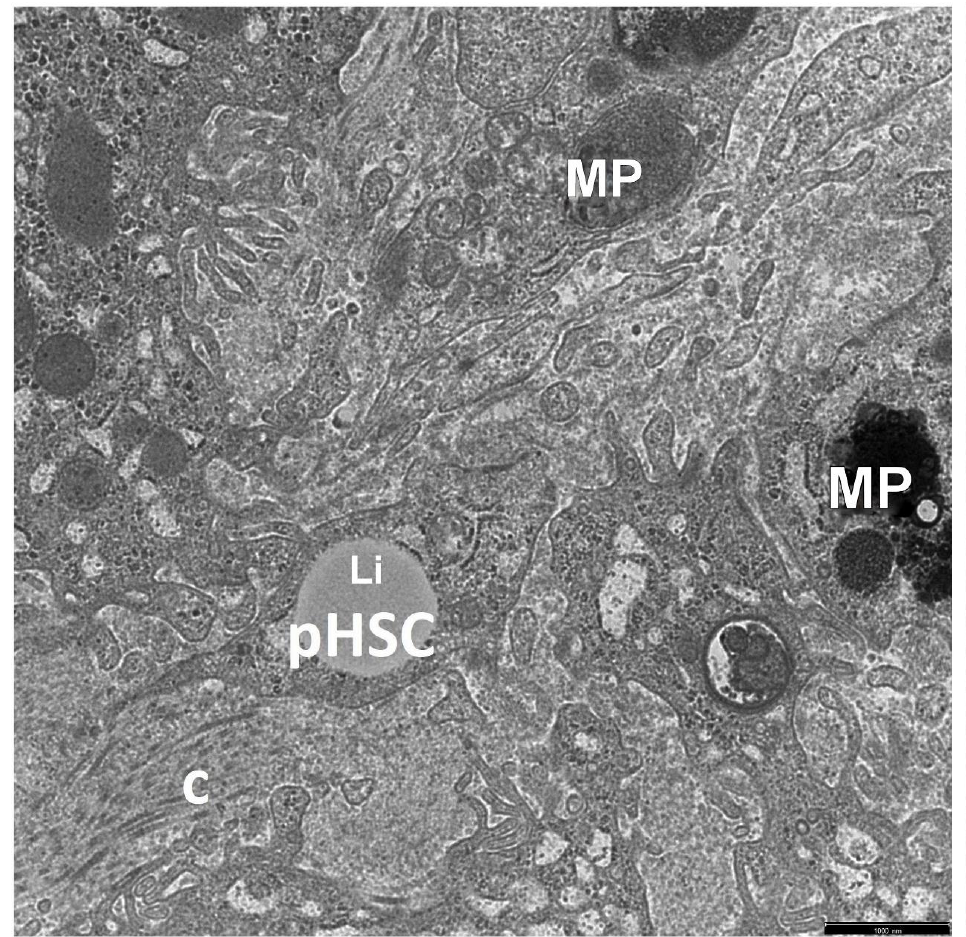
Figure 5. An electronogram demonstrating a pHSC, centrally located in the space between hepato- cytes, elongated and containing a relatively large single lipid droplet (Li). This cell is surrounded by thick bundles of collagen fibers (c). In very close vicinity, there are fragments of cells resembling activated Kupffer cells/macrophages (MPs ) outside the sinusoids. Scale bar 1 μm, original magnification ×12,000.